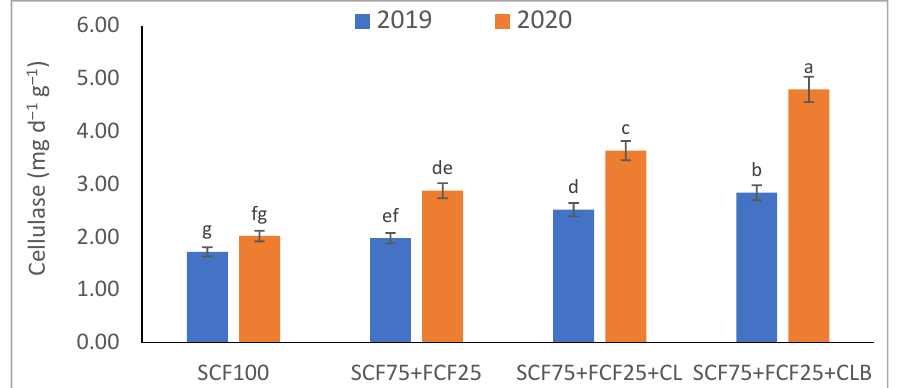
1. Bars with a different letter indicate significant difference between treatments at p ≤ 0.05.